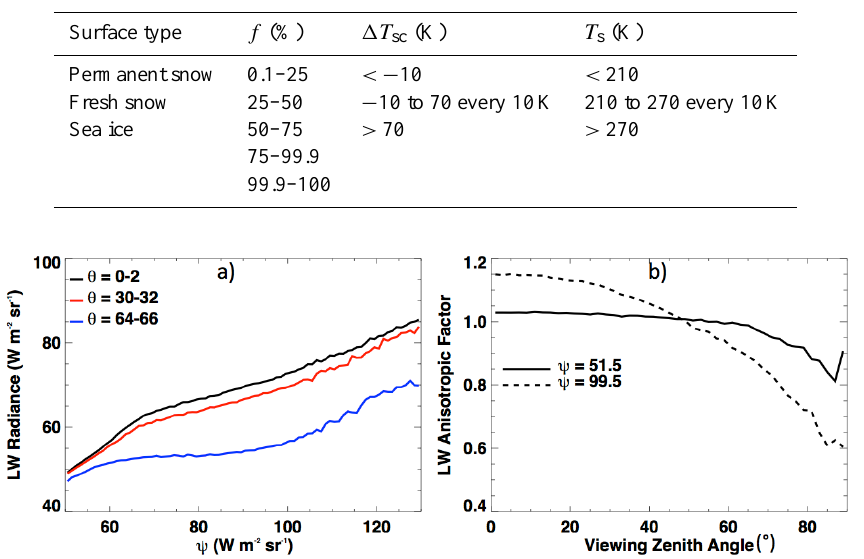
Figure 16. (a) LW radiance against ψ for three θ bins over ocean for w > 5cm, 65 <(cid:49)T sc < 70K, 300 <T s < 305K, and f = 100%. (b) LW Figure 16. a) LW radiance against ψ for three θ bins over ocean for w> 5 cm, 65 < ∆ T anisotropic factors for ψ = 51.5Wm − 2 sr − 1 and ψ = 99.5Wm − 2 sr − 1 300 <T 305 K, and f =100%. b) LW anisotropic factors for ψ =51.5Wm − 2 sr − 1 and ψ =99.5Wm − 2 sr − 1 . s <